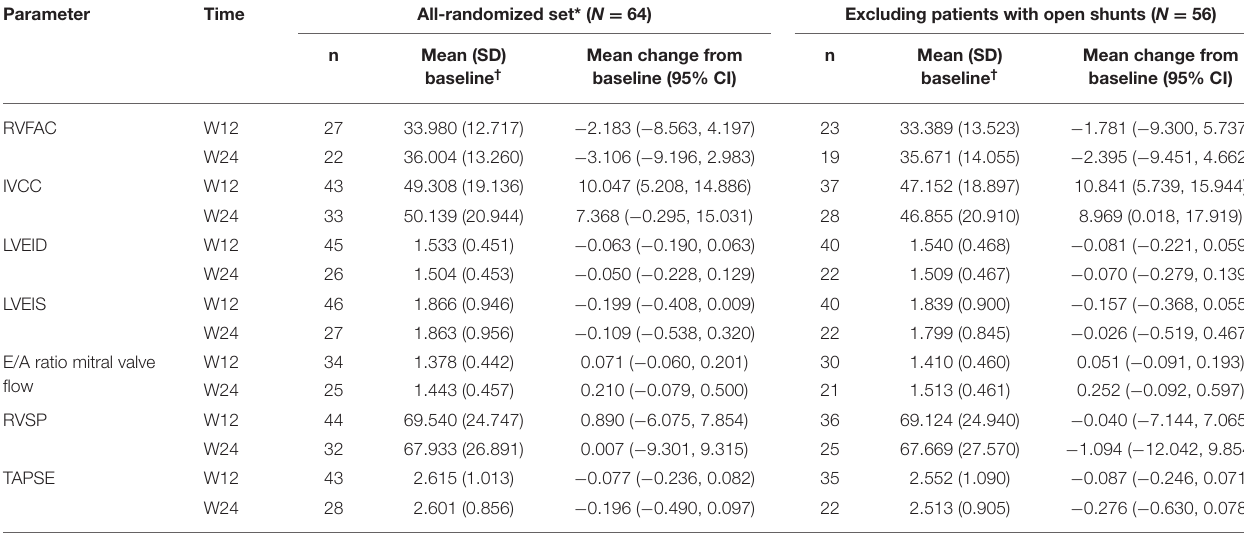
TABLE 2 | Changes in echocardiographic parameters from baseline in the all-randomized set and excluding patients with open systemic-to-pulmonary shunts. Parameter Time All-randomized set* ( N = 64) Excluding patients with open shunts ( N = 56) Mean change from Mean change from n Mean (SD) n Mean (SD) baseline (95% baseline (95% CI) baseline † baseline †